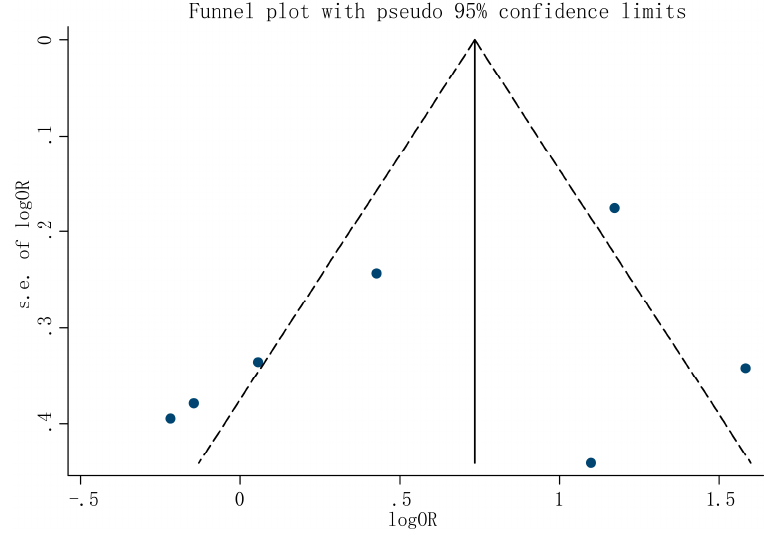
Figure 6. Funnel plot to explore publication bias.